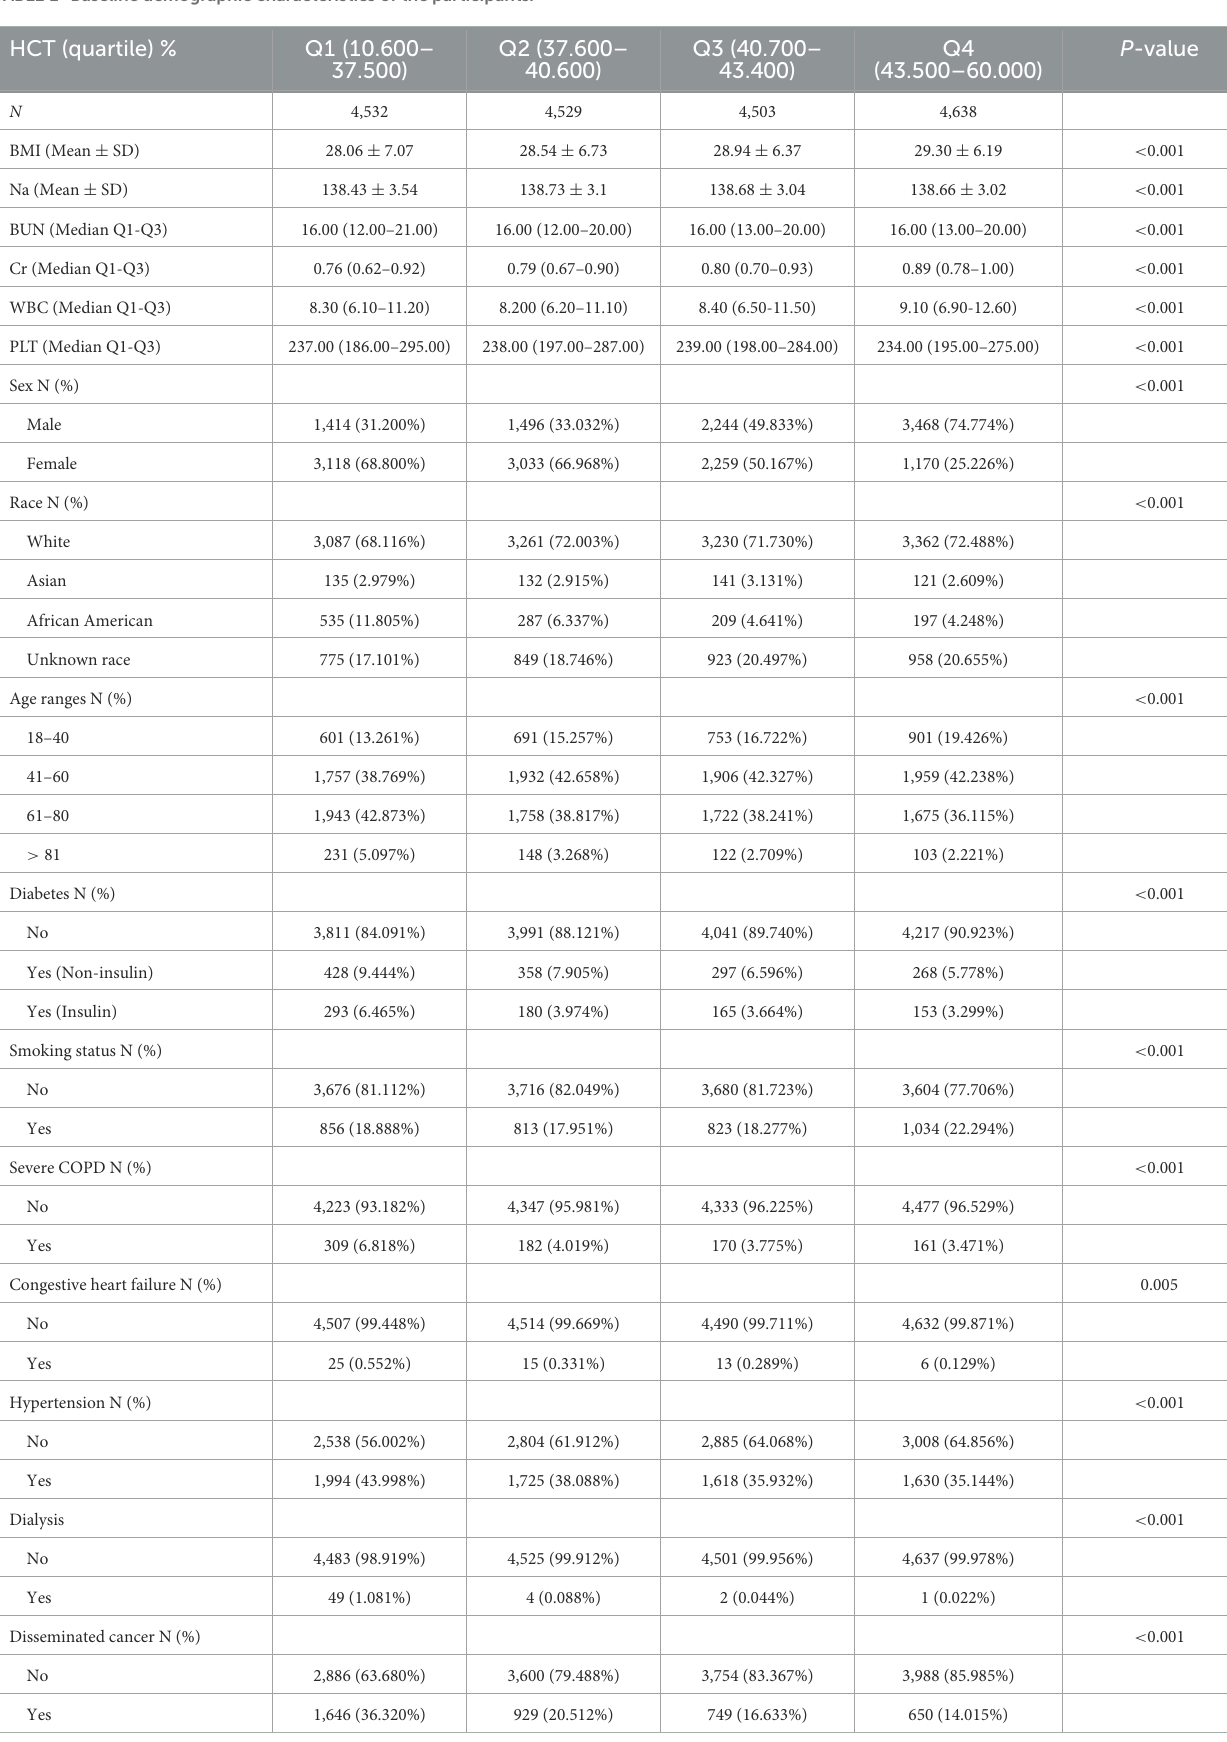
TABLE 1 Baseline demographic characteristics of the